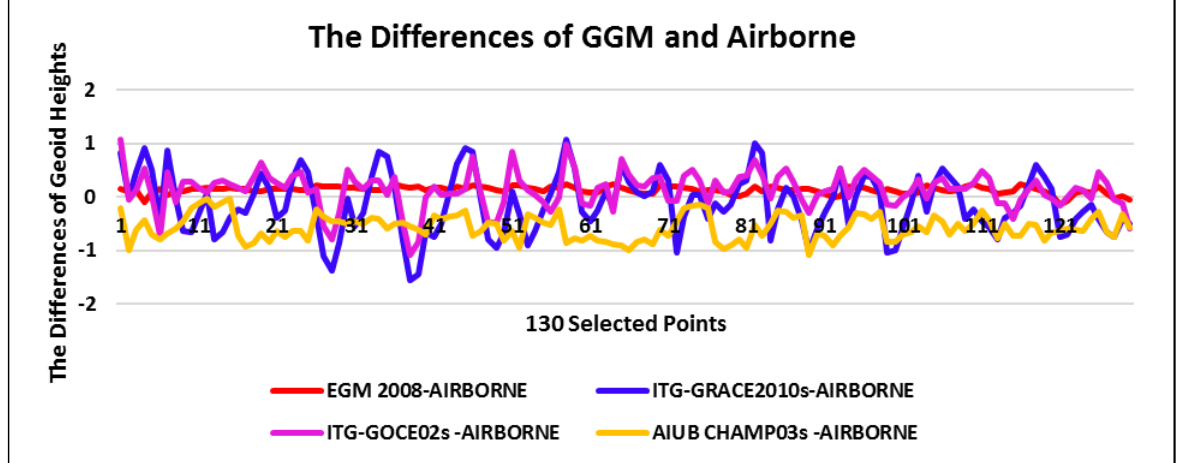
Figure 7. The difference of GGM data (EGM 2008, ITG-GOCE02s, ITG-GRACE2010s and AIUB CHAMP03s) with airborne gravity